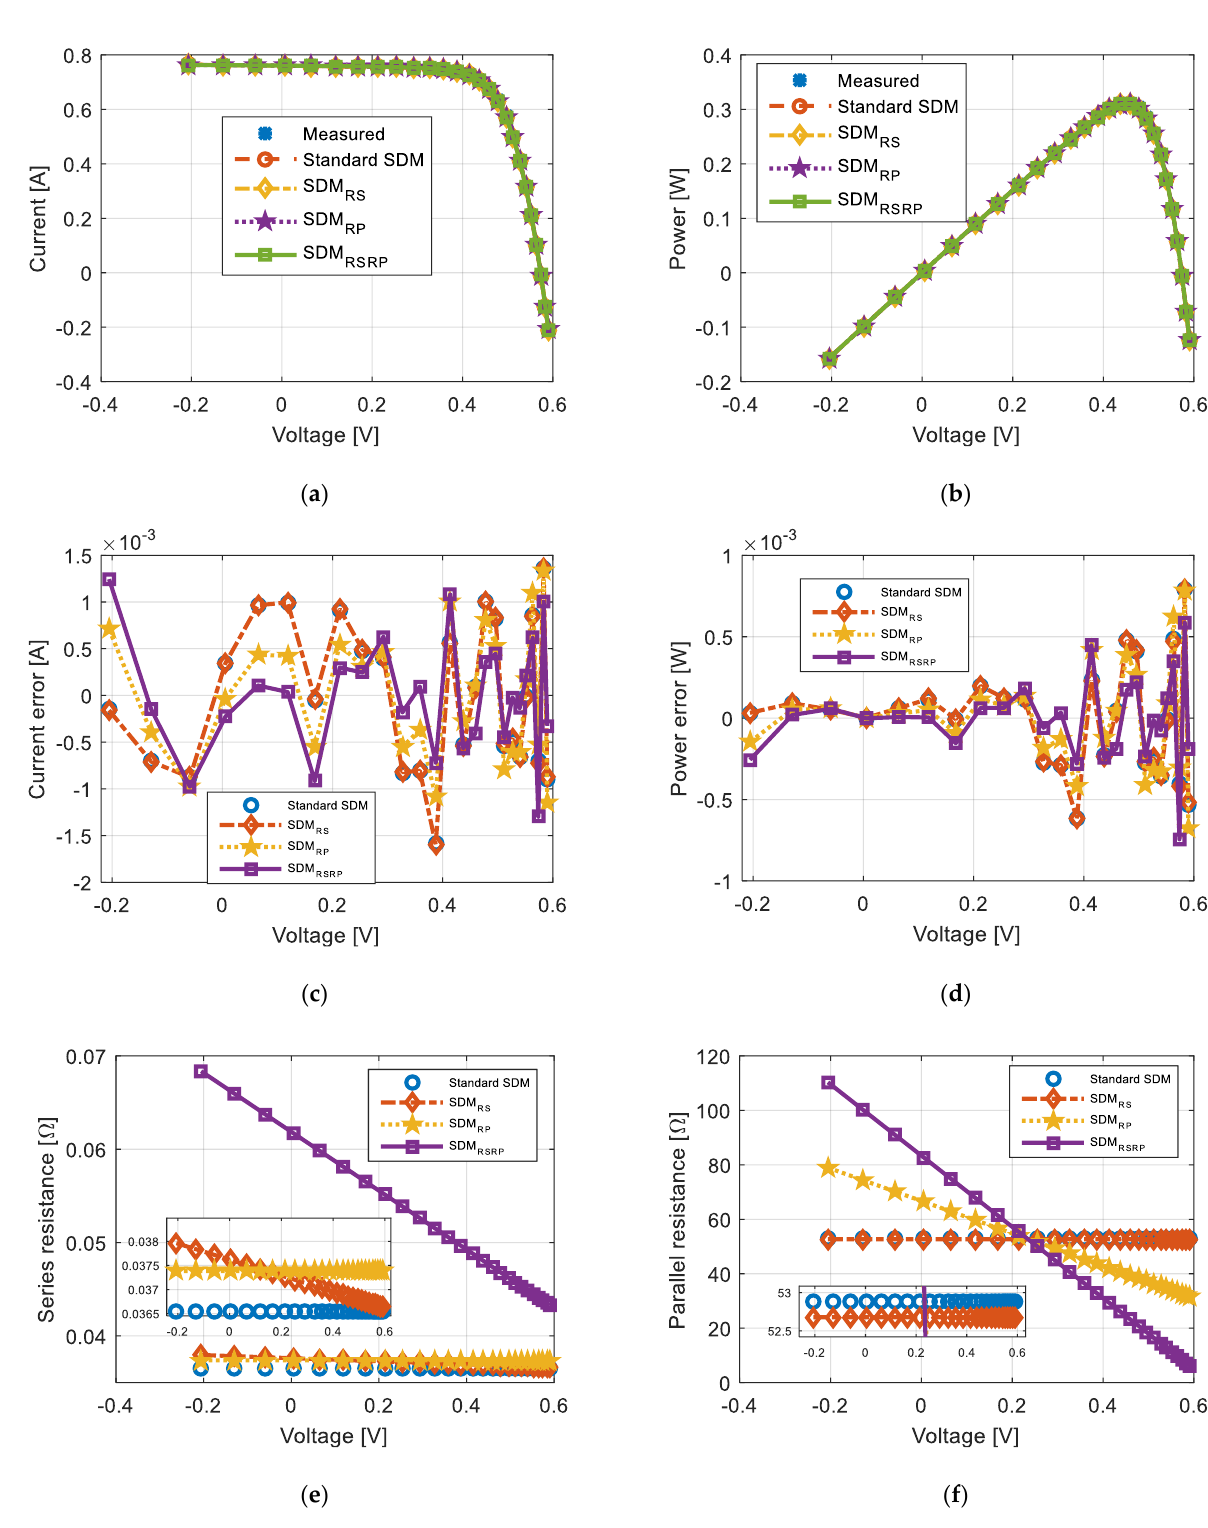
Figure 9. RTC France solar cell: ( a ) current-voltage characteristics; ( b ) power-voltage characteristics; ( c ) corresponding current-voltage errors; ( d ) corresponding power-voltage errors; ( e ) series resistance – voltage dependence characteristics; ( f ) parallel resistance – voltage dependence characteristics.